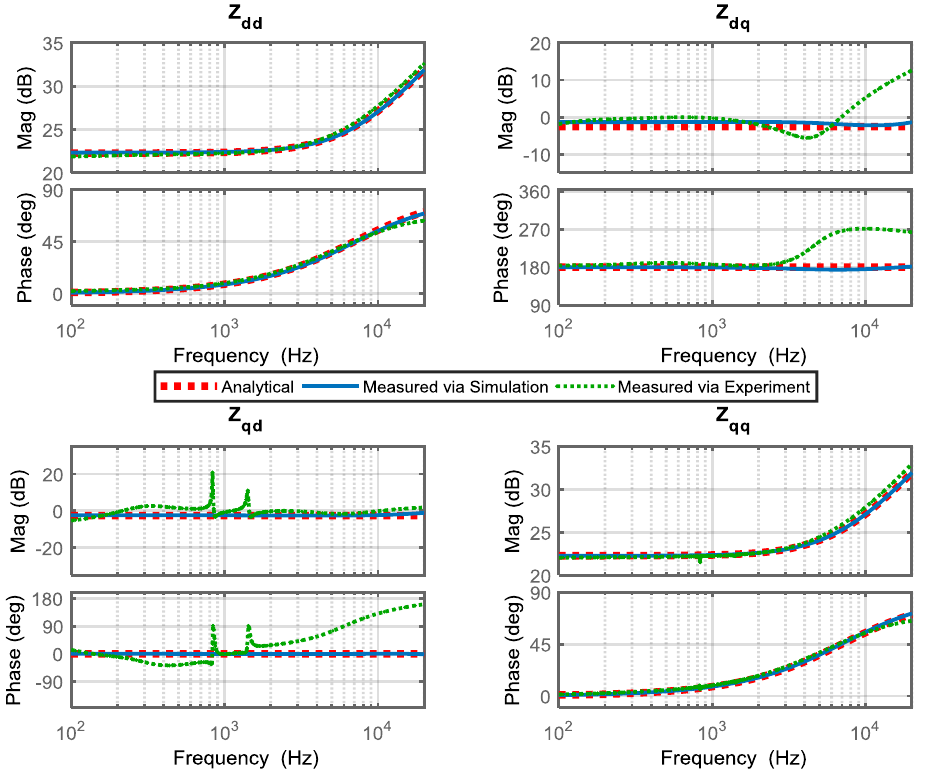
Figure 11. Comparison of analytical and measured Z -parameters for simulated and experimental RL networks.